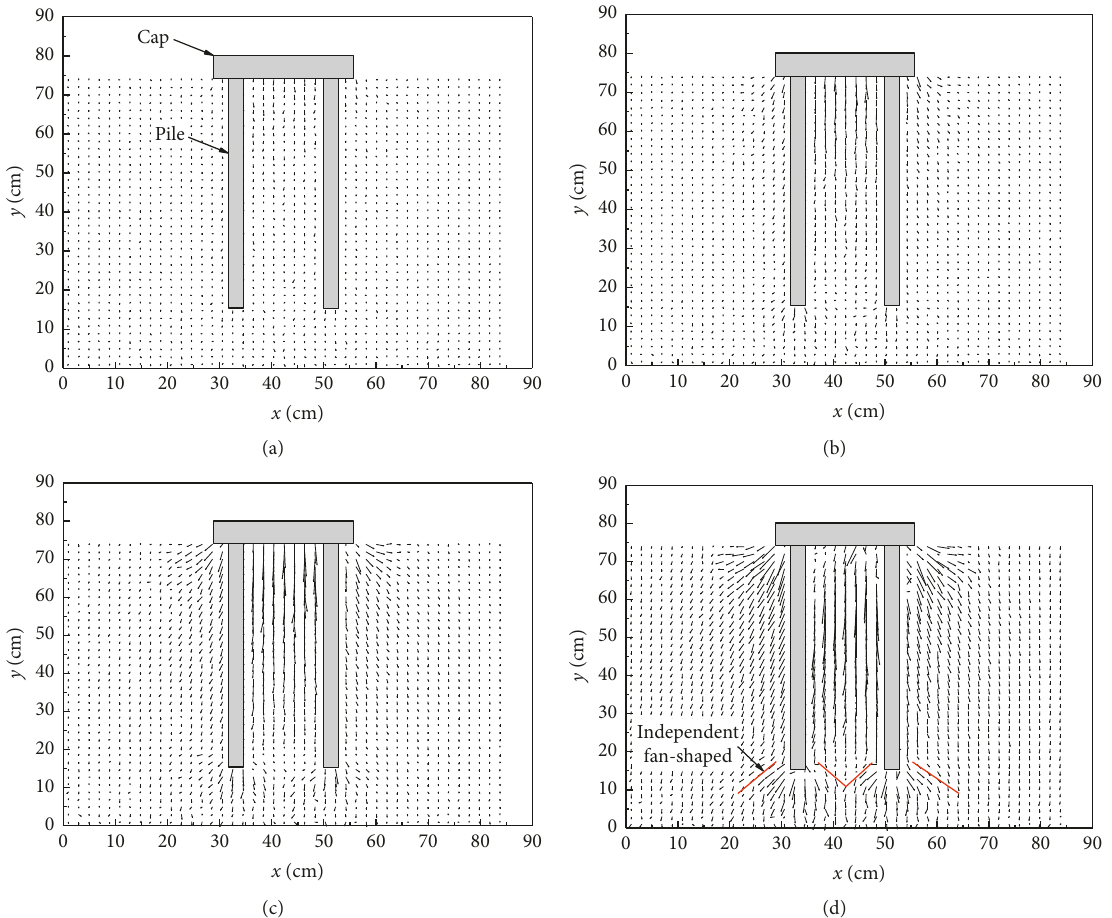
Figure 7: The sand displacement field of the pile group with 6 b pile spacing. (a) S � 2.055mm. (b) S � 5.2075mm. (c) S � 9.805mm. (d) S � 20.3125mm.